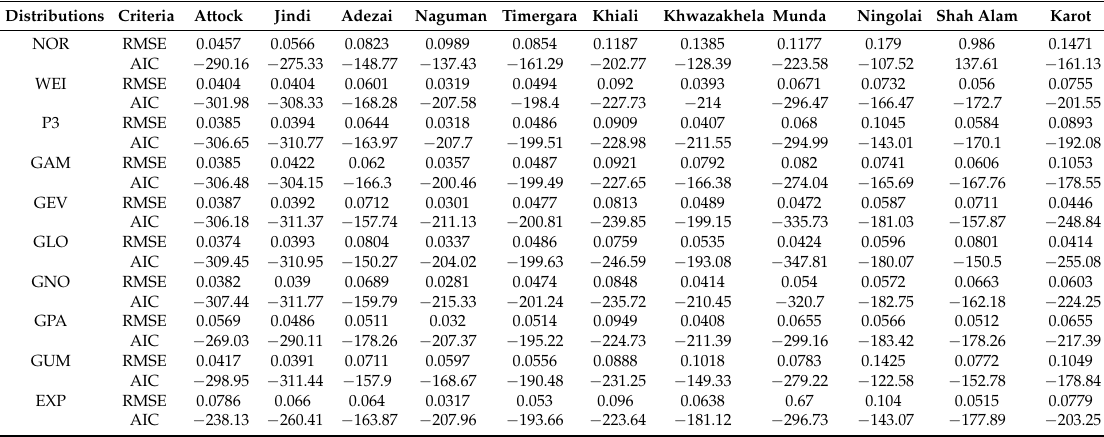
Table 4. Calculated values of Akaike information criteria (AIC) and root mean square error (RMSE) of probability distributions for different locations.